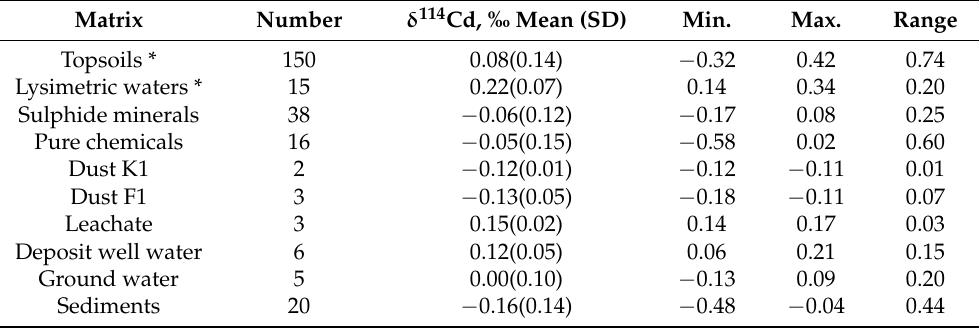
Table 5. Cadmium isotopic composition in environmental, geological, and industrial samples. Matrices marked * reported from previous studies